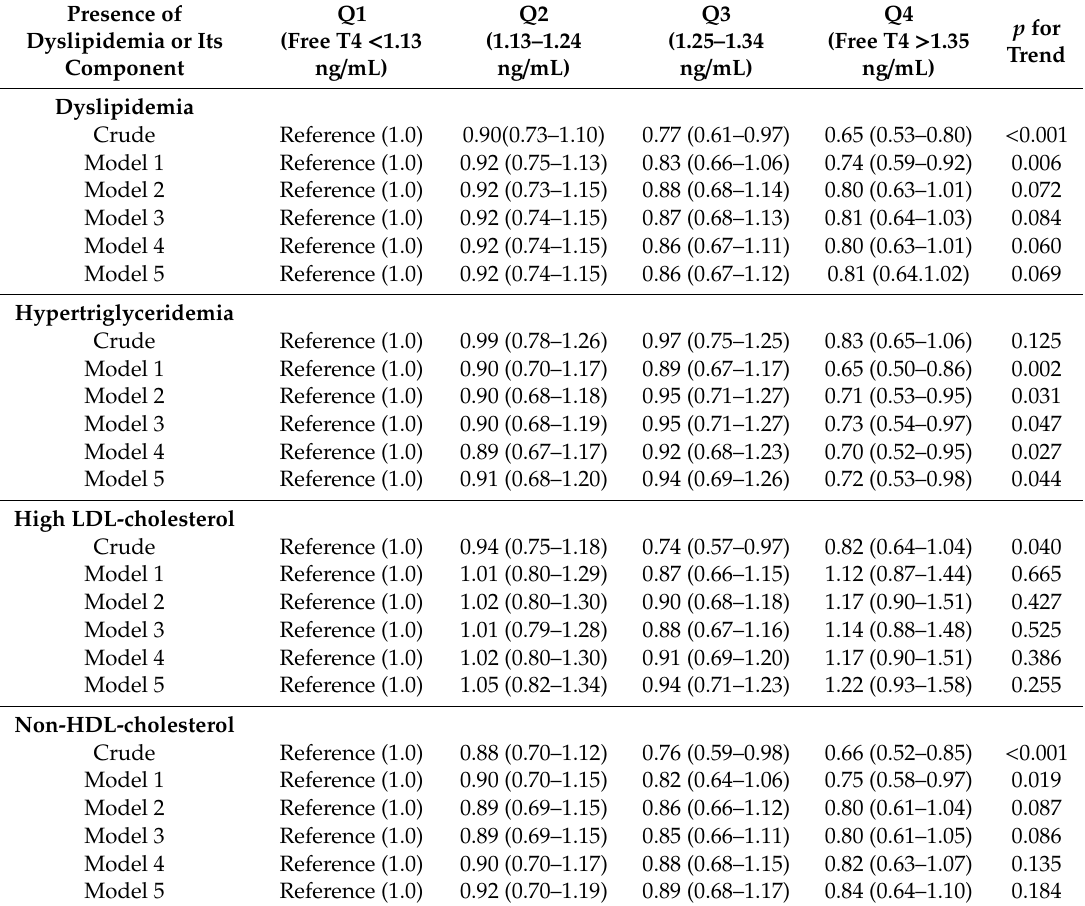
Table 3. Risk of dyslipidemia according to free T4